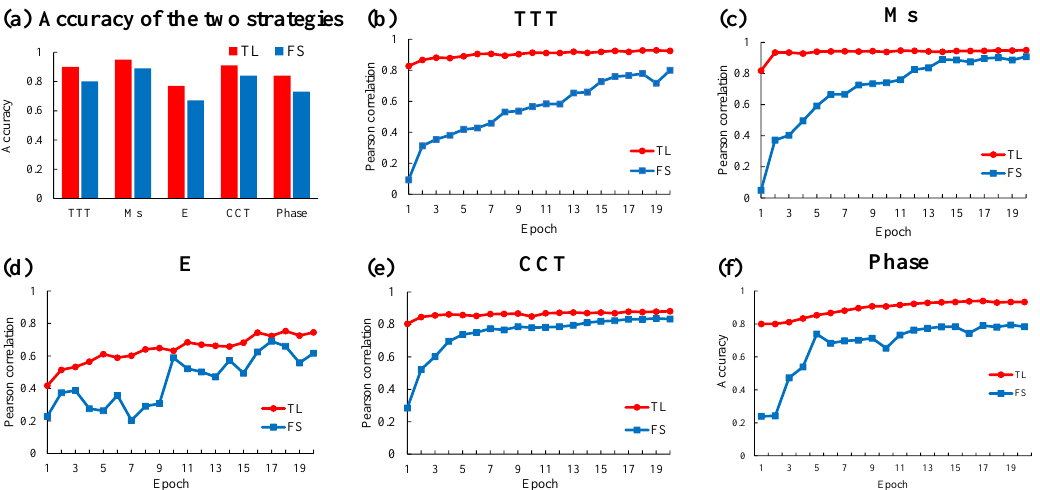
Figure 6. Effectiveness of transfer learning. ( a ) Comparison of the accuracy of the two strategies in the experimental data of each task. ( b – f ) Visualization of two strategies in the training process of each